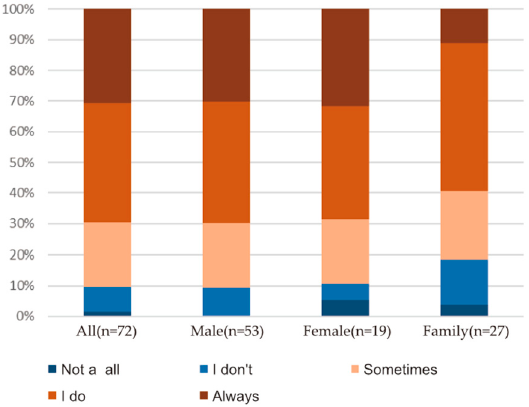
Figure 4. Current practice of considering traffic congestion to adjust departure time for returning home.